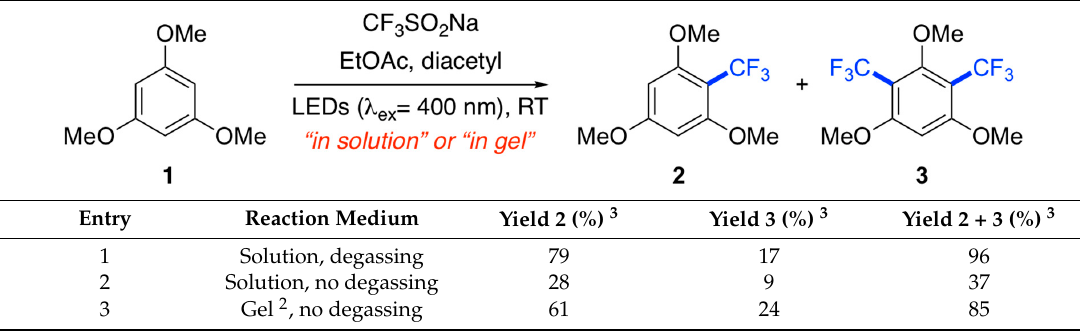
Table 1. Preliminary control trifluoromethylation reactions in solution and gel media. 1